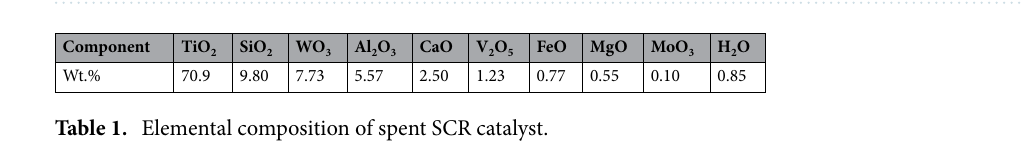
Figure 7. SEM–EDS images and element composition of leached catalyst.